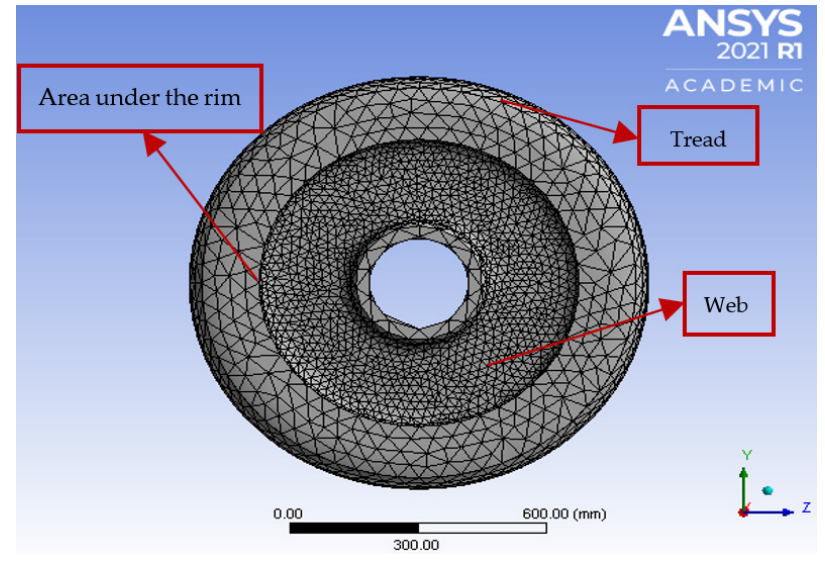
Figure 5. Finite element model of D39200 locomotive wheel.